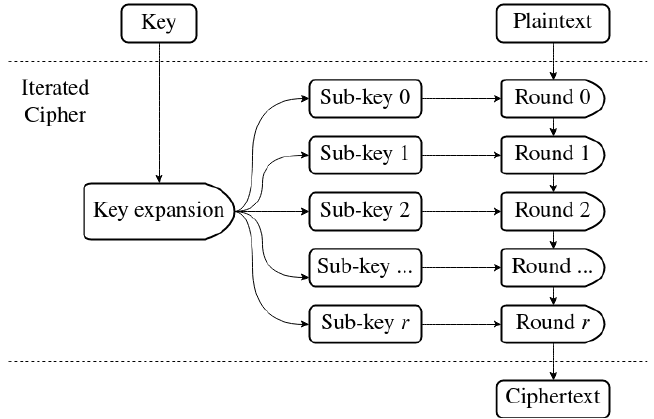
Figure 2. Encryption in an iterated cipher with r number of rounds.